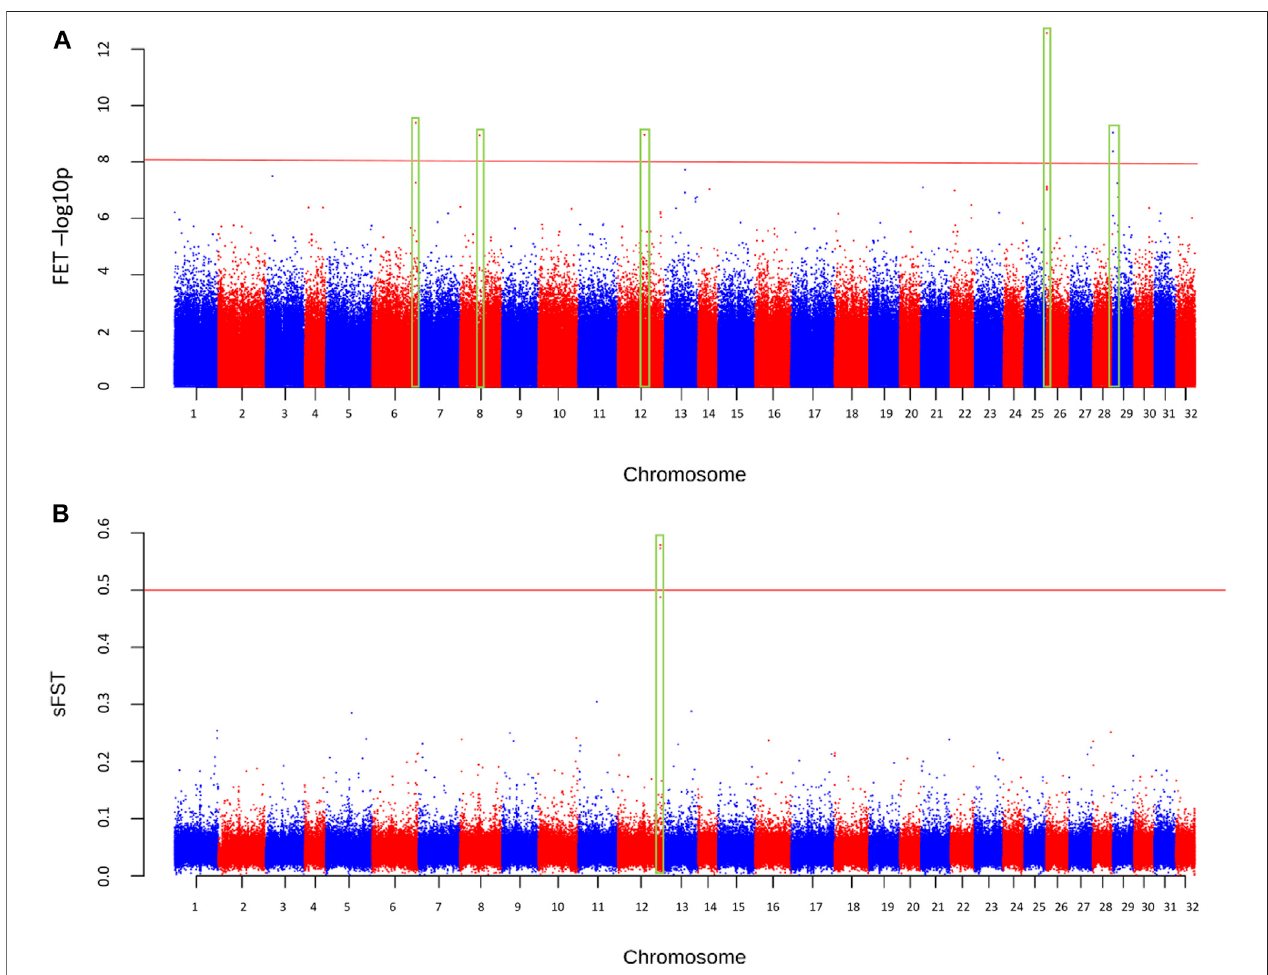
FIGURE 4 | Manhattan plot of differences in allele frequencies between resident and anadromous collections across the genome based on (A) signi fi cance from Fisher ’ s exact test (FET), and (B) sliding window F ST (sF ST ). The minimum coverage threshold was 15 reads and the minor allele frequency was > = 0.05.